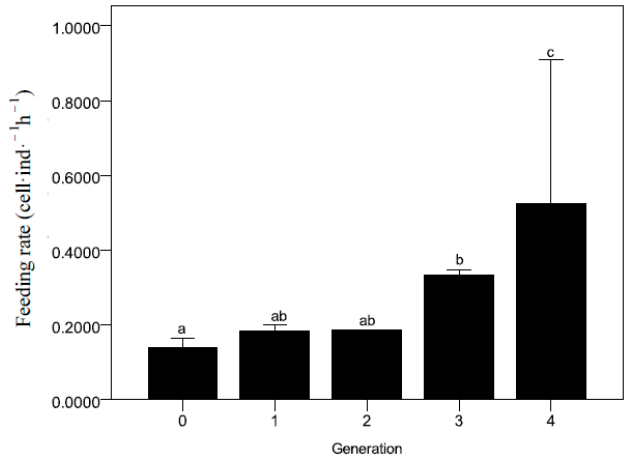
Figure 6. Effect of seawater acidification on the ingestion rate (mean ± standard deviation, n = 3) of T. japonicus in five generations. Successive generations were exposed to a lower pH than their parents. Statistical differences among generations ( p < 0.05) are represented by different letters.